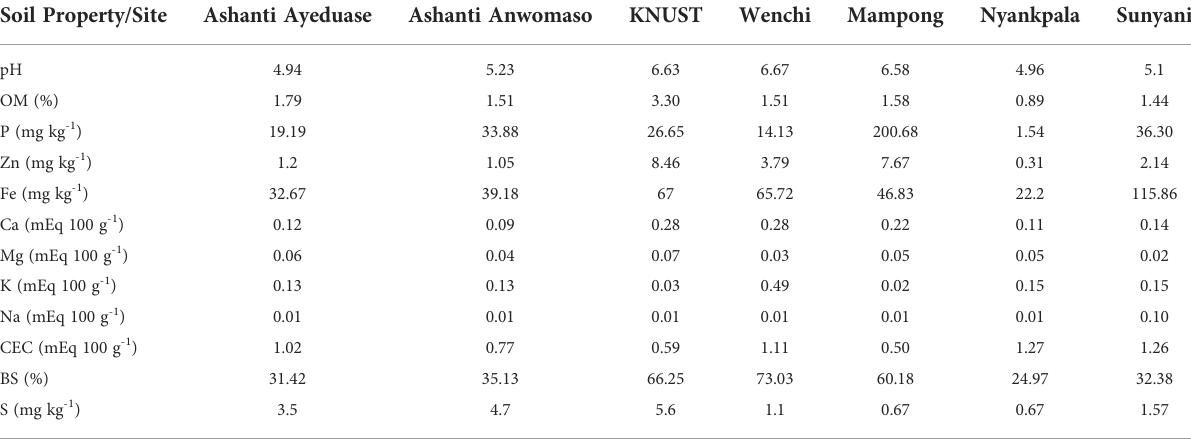
TABLE 4 Soil properties of sampled soils at the experimental sites. Soil